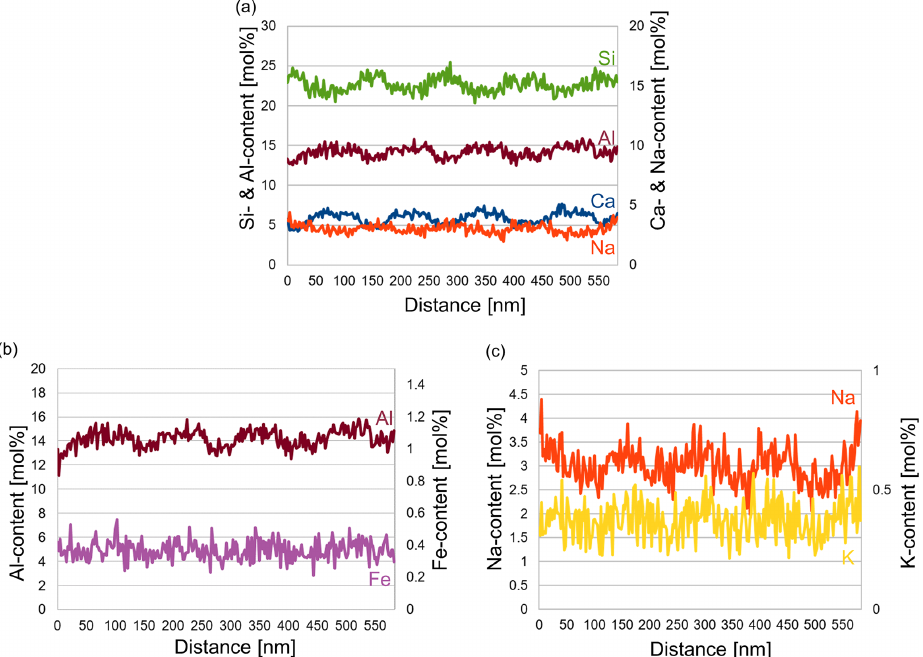
Figure 8. EDS line scans with the element content (in mol%) plotted against distance in nanometers. (a) Si, Al, Ca and Na; (b) Al and Fe; (c) Na and K. In order to display the trend of each element, there are two y axes in each diagram.